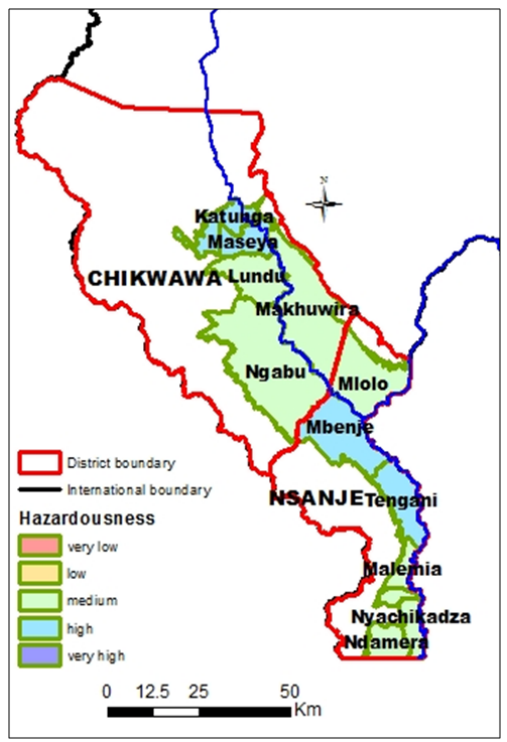
Figure 3. Spatial variation in flood hazardousness in the Lower Shire Valley.